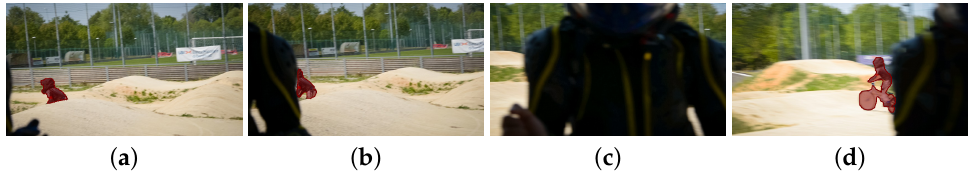
Figure 4. A rider on a bicycle disappears and reappears in the “BMX-bumps” sequence. ( a ) Frame 55; ( b ) Frame 58; ( c ) Frame 70; ( d ) Frame